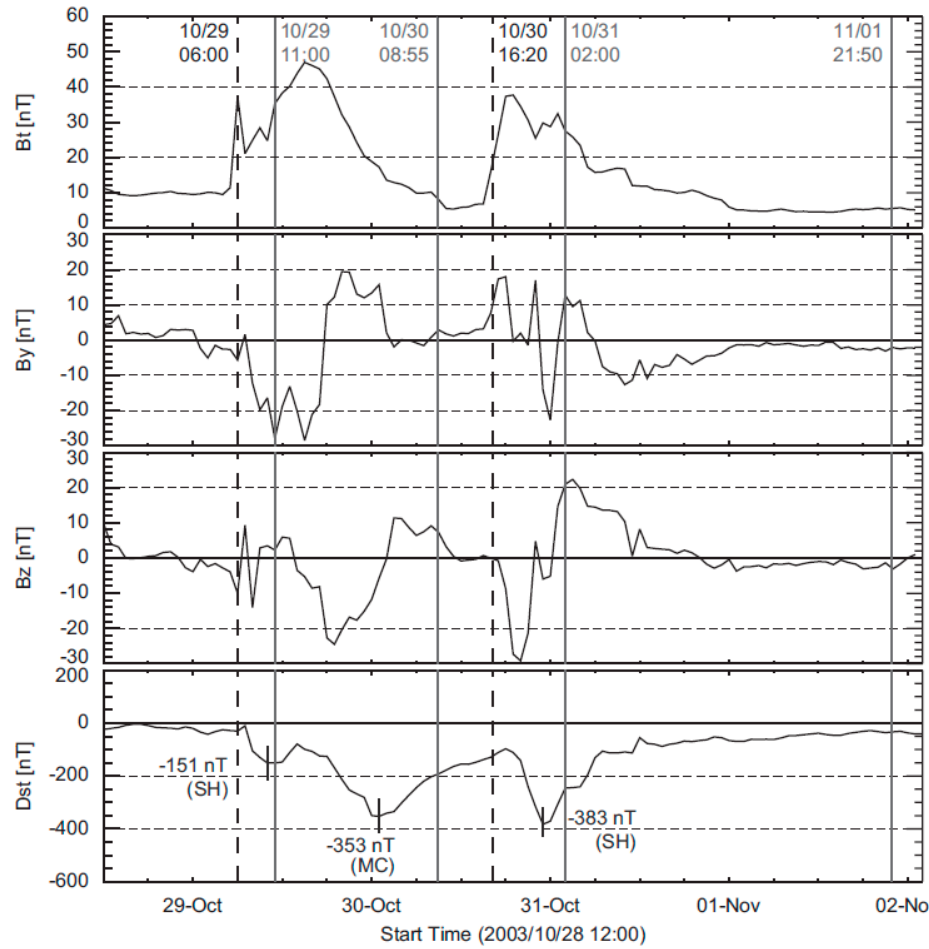
Figure 12. Two super-intense magnetic storms from the Halloween 2003 period, one caused by an FS MC, the other caused by a sheath. The underlying CMEs originated from the same active region, one day apart (from [115]).